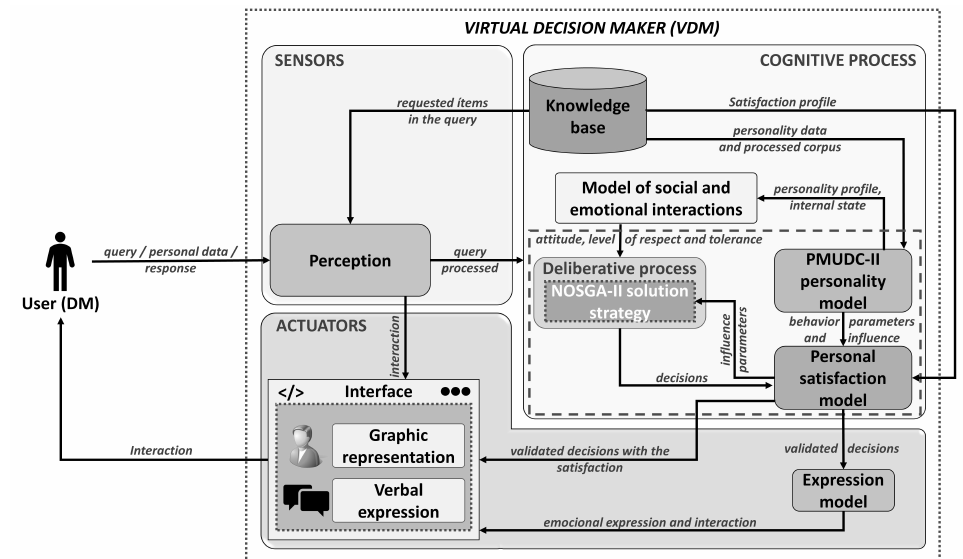
Figure 1. VDM architecture is composed of the satisfaction model, NOSGA-II, and PMUDC-II.